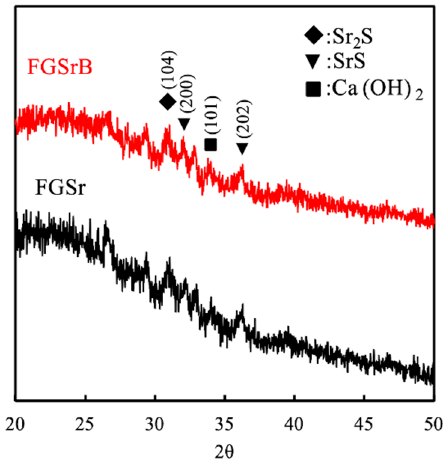
Figure 2. XRD for specimens prepared with a series of FGSr and FGSrB scaffolds.